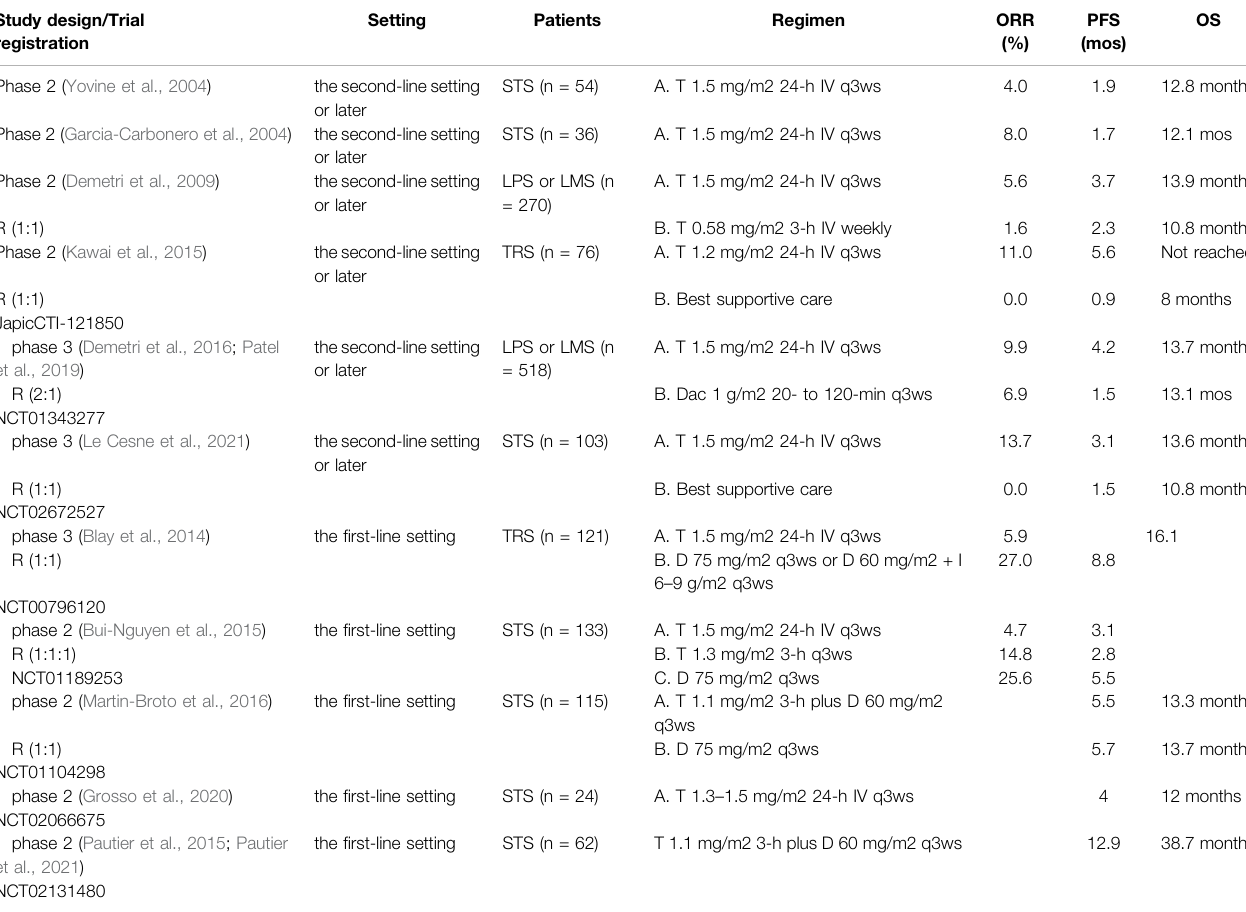
TABLE 1 | clinical trials for advanced STS. Study design/Trial